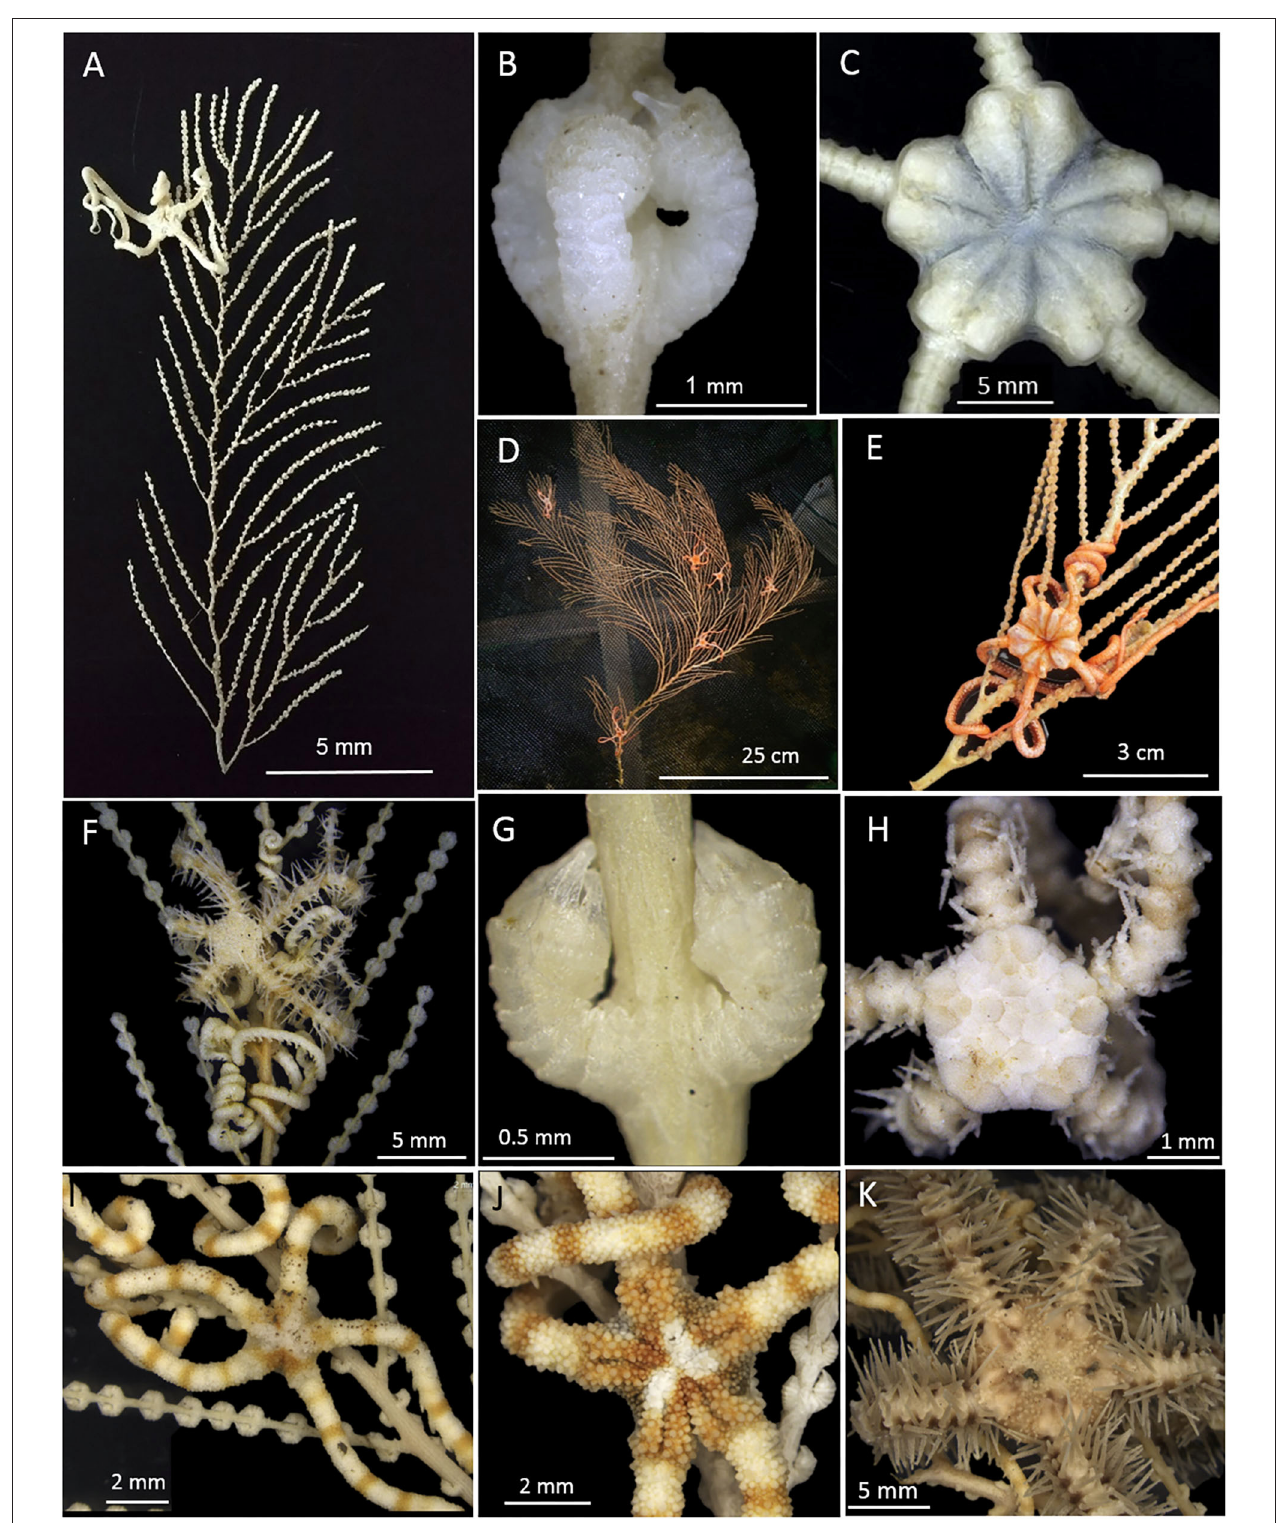
FIGURE 2 | Octocorals and brittle stars found associated in the Colombian Pacific and Colombian Caribbean Sea. Pacific specimens: (A) Fragment of the octocoral Callogorgia cf. galapagensis associated with the brittle star Astrodia cf. excavata . (B) Whorl of polyps of C . cf. galapagensis . (C) Disc of A. cf. excavata (D,E) Color of C. cf. galapagensis and A. cf. excavata in live specimens. Caribbean specimens: (F) Association among the octocoral Callogorgia gracilis and the brittle stars Asteroschema oligactes and Ophiomitra valida . (G) Whorl of polyps of C. gracilis . (H) Juvenile of O. valida . (I,J) A. oligactes . (K) Adult specimen of O. valida .